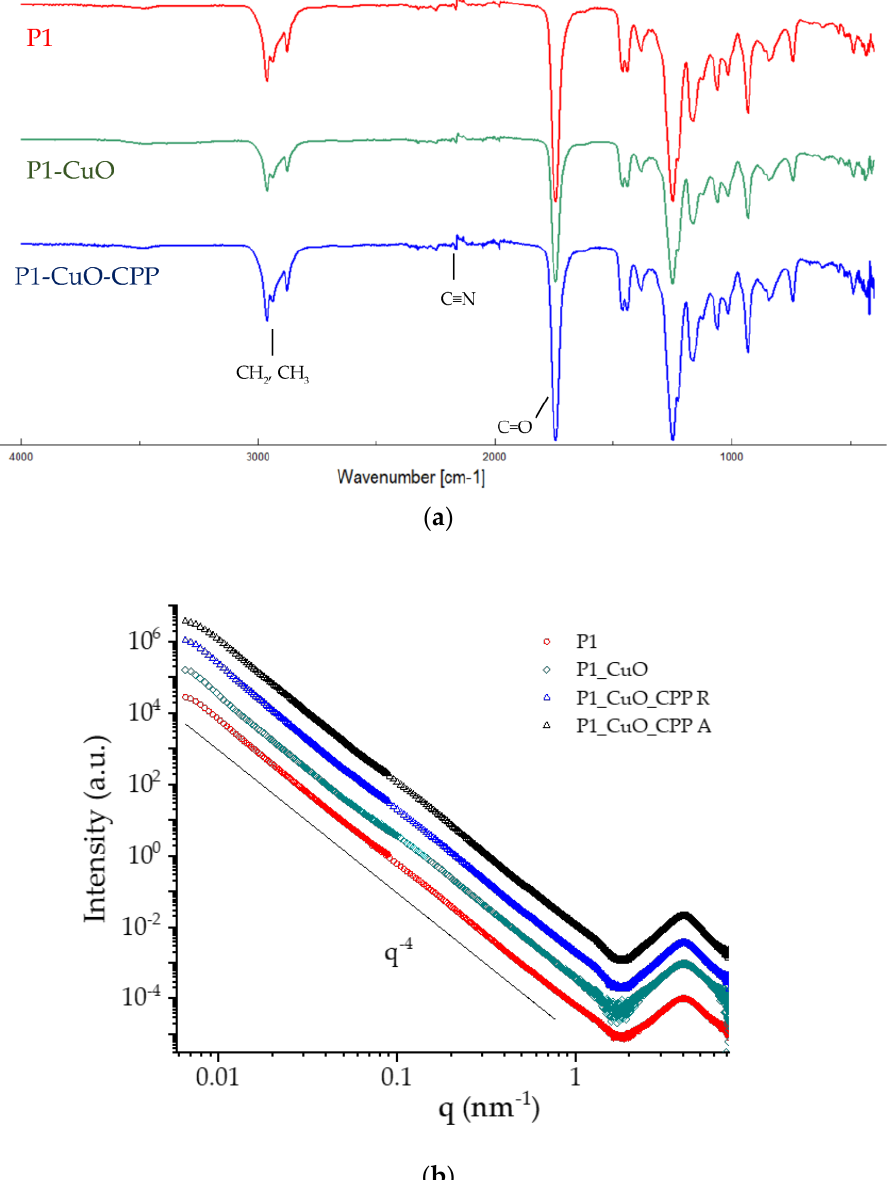
Figure 5. ( a ) FTIR spectra of P1, P1-CuO, and P1-CuO-CPP scaffolds. ( b ) SAXS spectra of P1, P1-CuO, and P1-CuO-CPP scaffolds randomly collected (R) and of P1-CuO-CPP aligned (A). The intensity profiles were vertically shifted for better visibility.